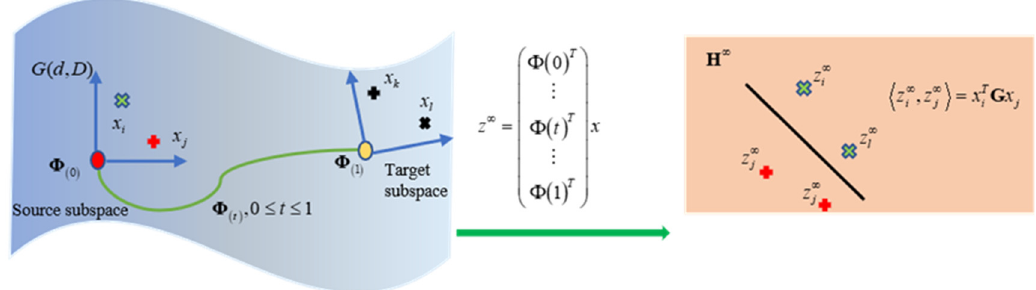
Figure 2. Basic idea of the GFK for domain adaptation.